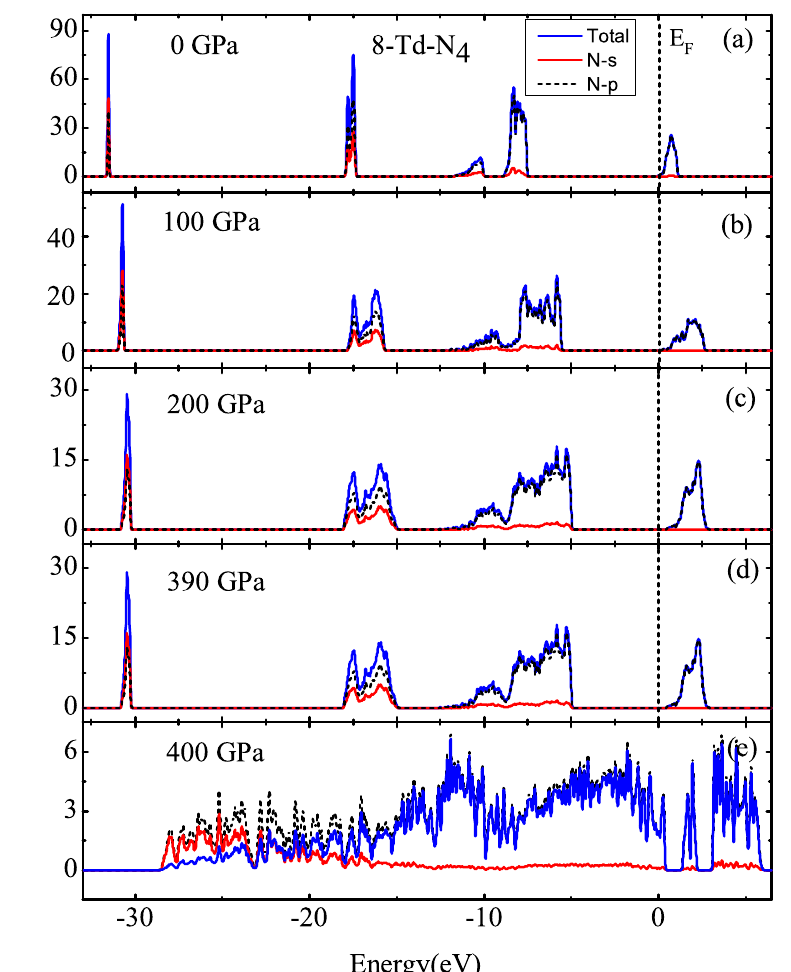
Figure 9. DOS of 8-Td-N 4 : ( a ) 0 GPa, ( b ) 100 GPa, ( c ) 200 GPa, ( d ) 390 GPa, ( e ) 400 GPa. Fermi level E F was set to be